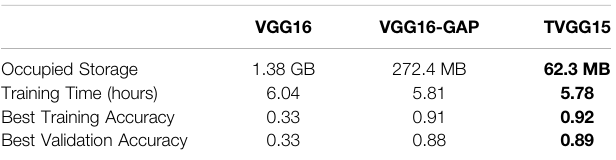
TABLE 3 | Model training